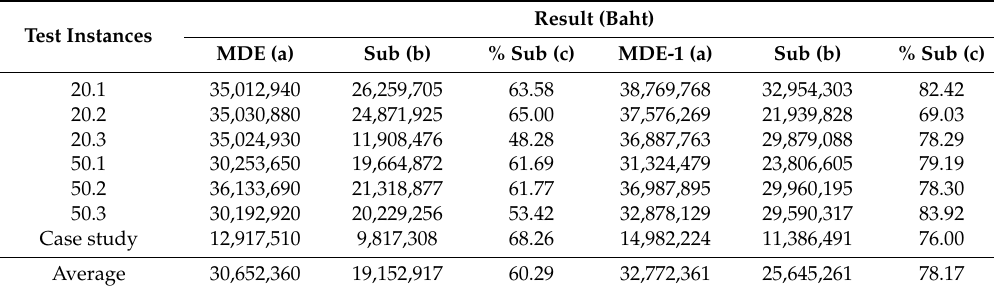
Table 14. Results of MDE and MDE-1.